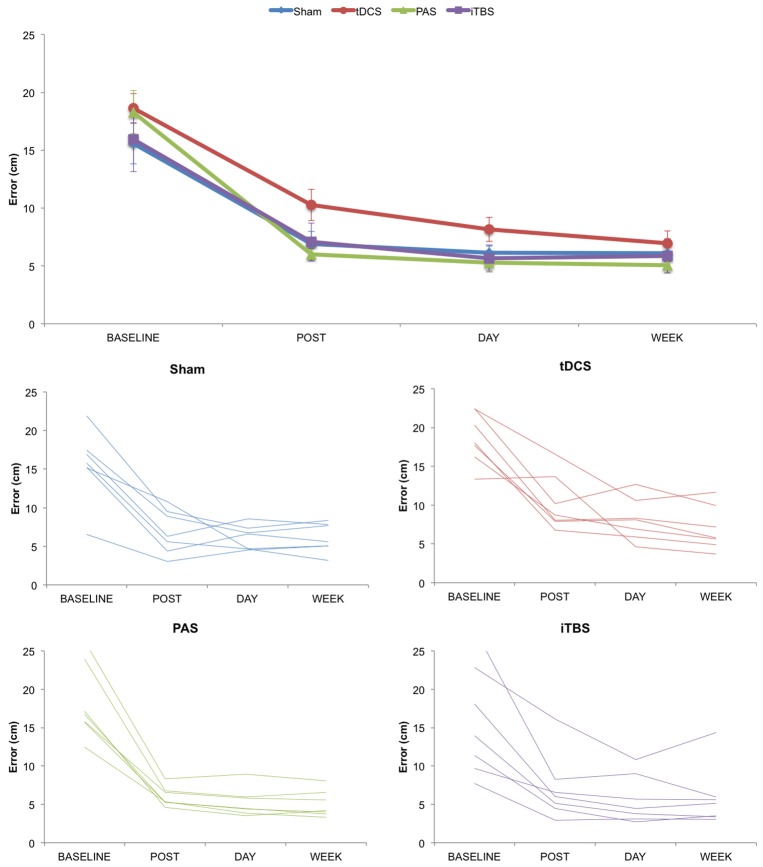
Change in motor learning as measured by error rate over time. (Top) Group averaged data for motor learning. (Bottom) Plots for Sham, tDCS, PAS25, and iTBS groups showing individual subject data. Error bars represent standard error.